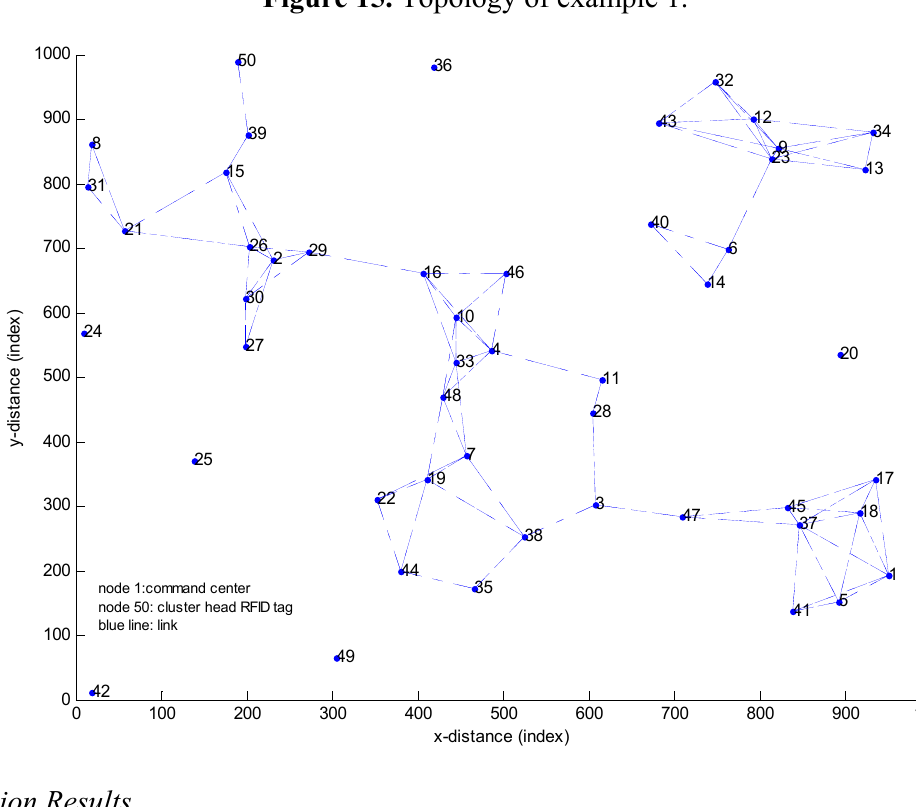
Figure 15. Topology of example 1.